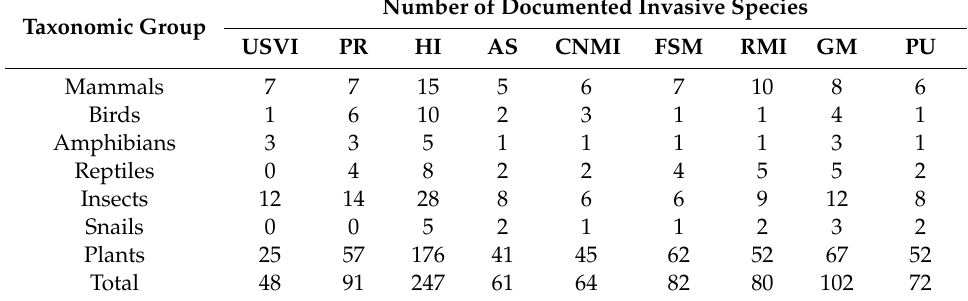
Table 5. Number of documented invasive terrestrial species in the U.S. and U.S. a ffi liated tropical islands (listed east to